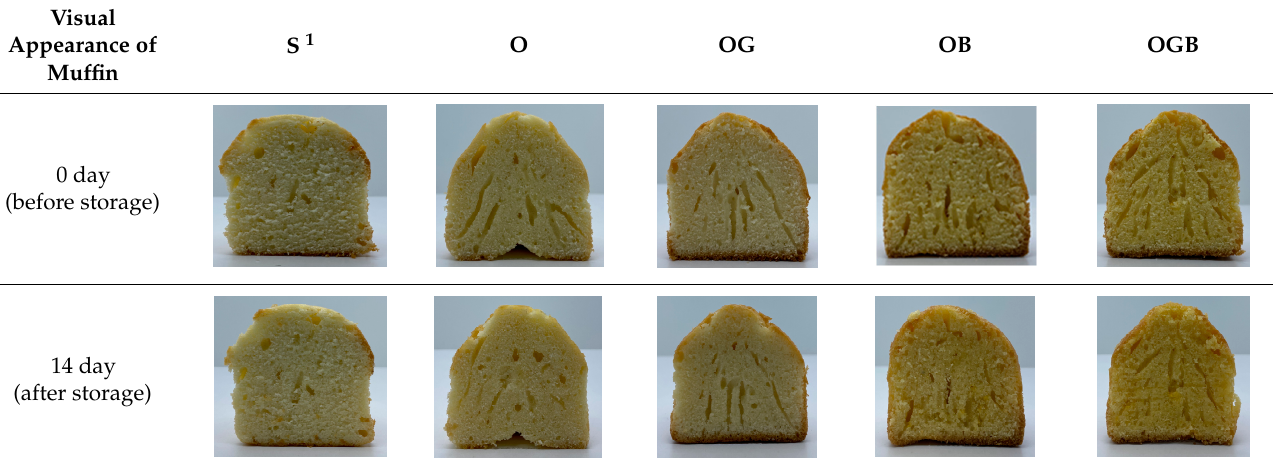
Table 2. Effect of shortening replacement with oleogels on the visual appearances of muffins.